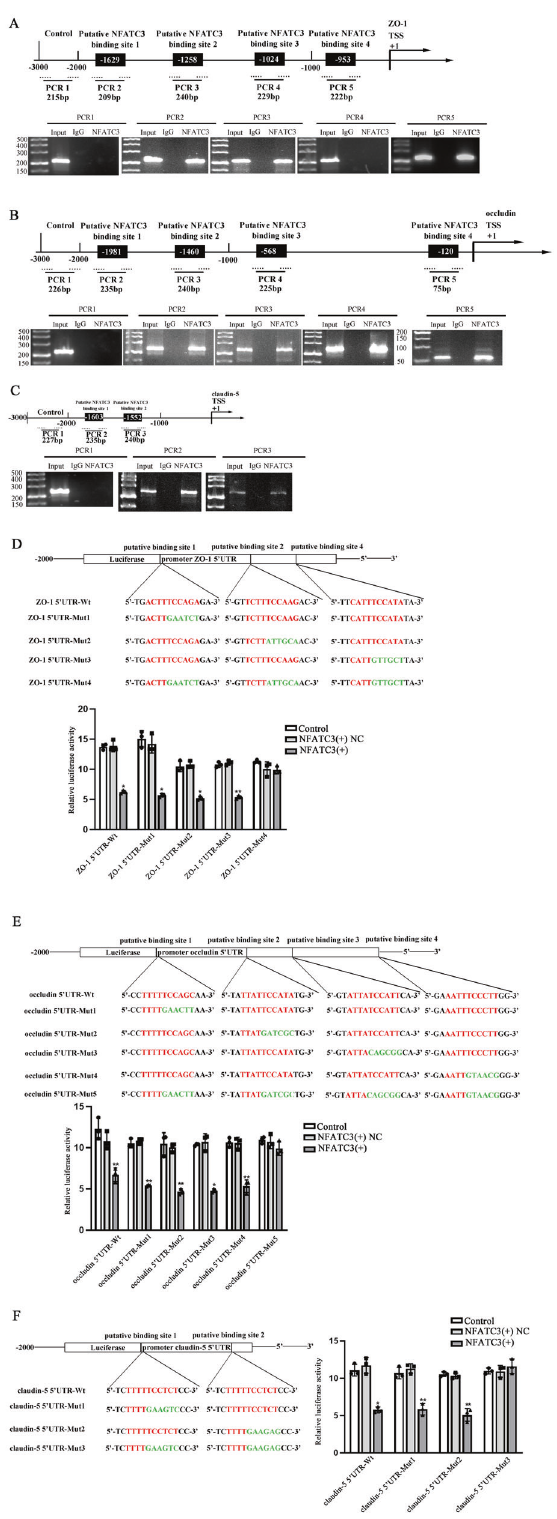
Fig. 8 NFATC3 inhibited TJ-related proteins expression by acting as a transcription factor. A – C Diagram above represented the predicted promoter regions of ZO-1, occludin and claudin-5 in 3000 bp upstream of the transcription start site (TSS, designated as + 1). Chromatin immunoprecipitation (ChIP) PCR was constructed for the binding sites and upstream regions not expected to interact with NFATC3 were used as negative control. Images below showed the PCR results by agarose gel electrophoresis. D – F Dual-luciferase reporter assays were applied to test the binding sites of NFATC3 with ZO-1, occludin and claudin-5. * p < 0.05 and ** p < 0.01 vs. NFATC3( + ) NC group, data were presented as mean ± SD ( n = 3,